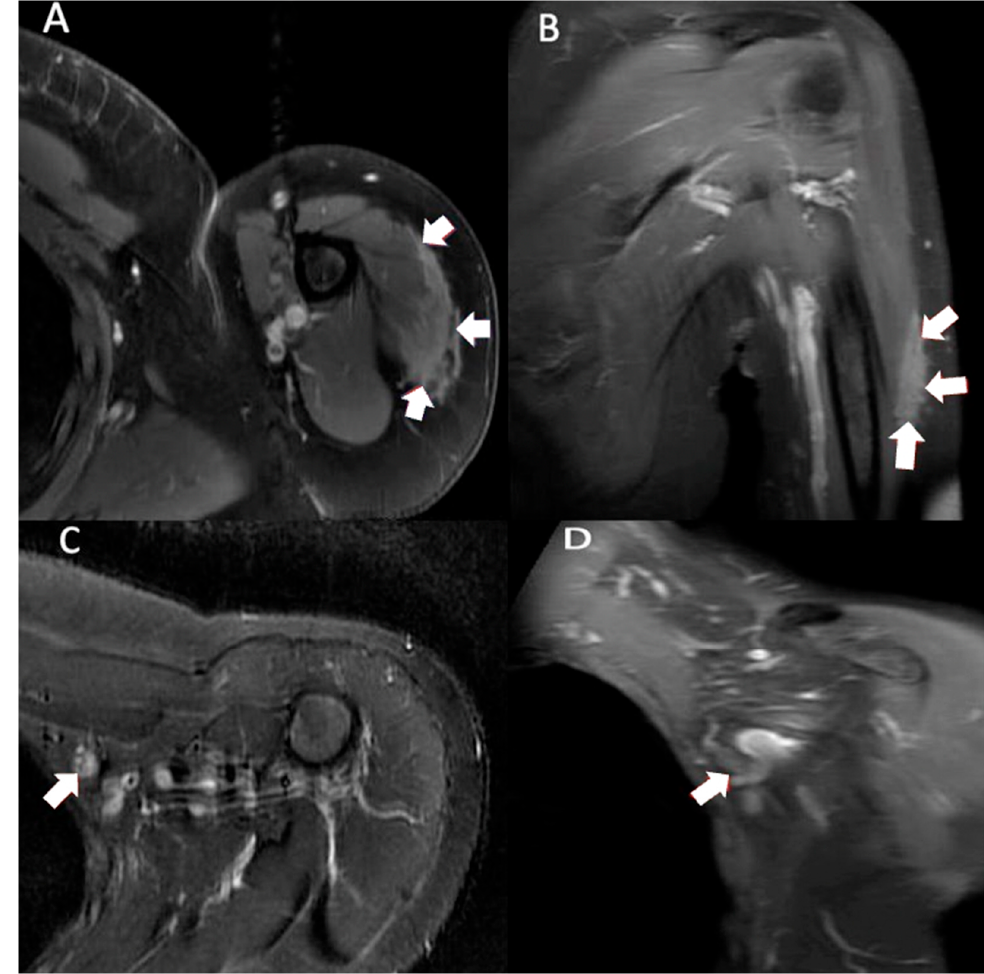
Figure 2. Multiplanar MRI of left shoulder taken 10 months after vaccine administration in left shoulder. Axial T1 weighted ( A ) image shows predominately intramuscular edema within the lateral deltoid muscle measuring 5.6 cm anterior-posterior and 1.0 cm medial-lateral (arrows). Coronal T1 weighted ( B ) image shows intramuscular edema within the lateral deltoid muscle measuring 10.0 cm proximal-distal (arrows). Axial T2 STIR ( C ) and coronal T1 weighted ( D ) images show a slightly enlarged left axillary node (9.9 × 11.2 × 12.8 mm) (arrows).